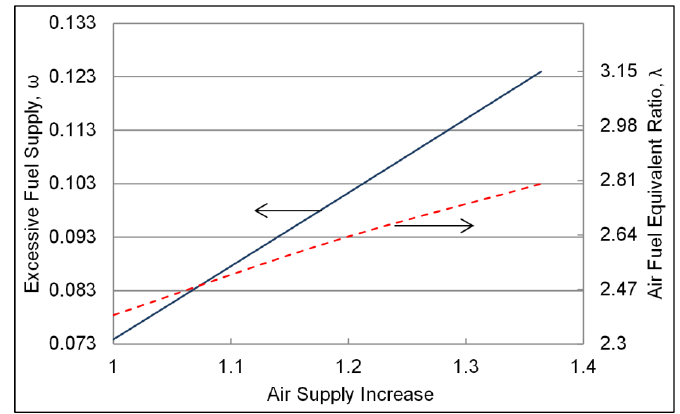
Figure 10. The effect of excessive air supply (air flow/initial air flow) on excessive fuel requirement, ω , and air fuel equivalent ratio, λ . T = 850 °C and S / B =